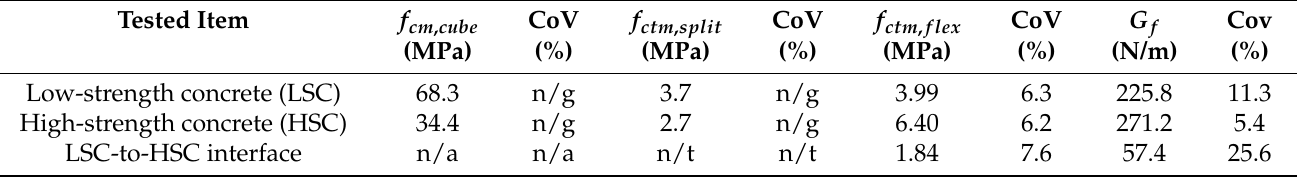
Table 1. The main laboratory tests outcomes from reference [26]. n/a—not applicable, n/t—not tested, n/g—not given. Tested